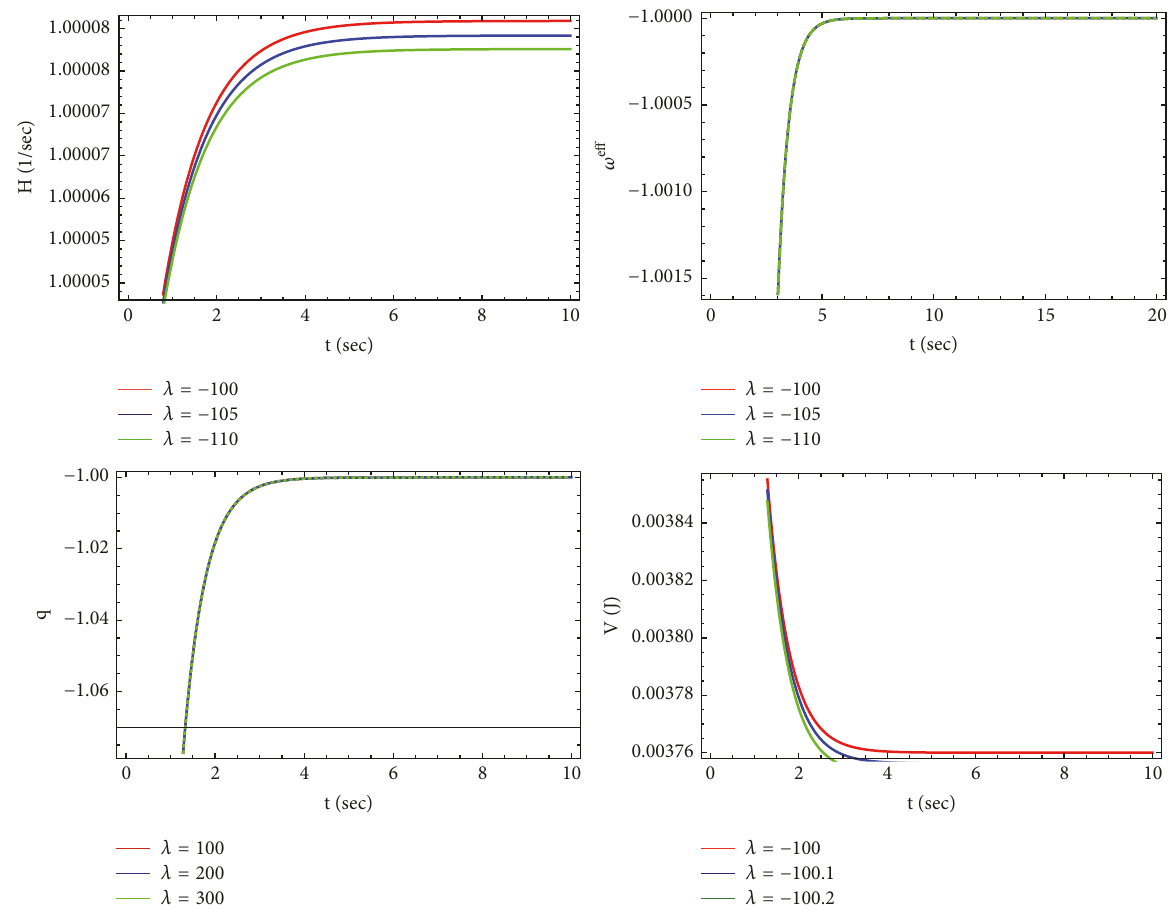
Figure 7: Plots of 𝐻 , 𝜔 𝑒𝑓𝑓 , 𝑞 , and 𝑉 versus 𝑡 for 𝑊(𝜑 − ) = 𝑒 𝑏 1 𝜑